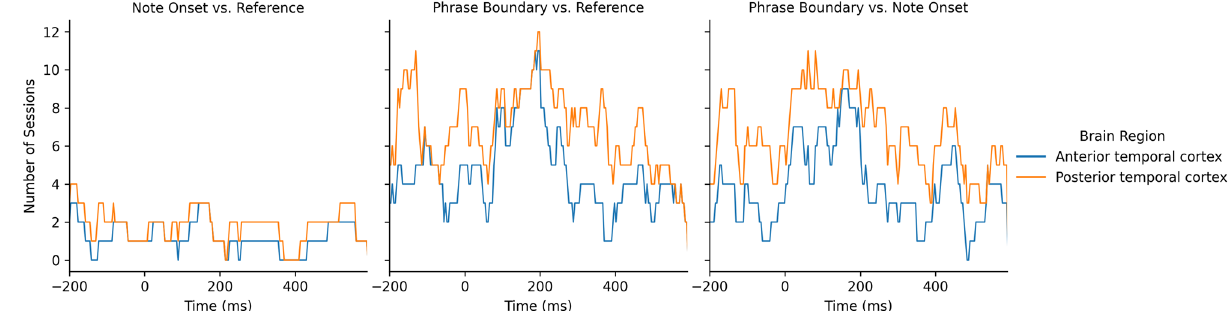
Figure 12. Number of sessions showing significant differences in the iEEG windows sampled in anterior temporal cortex and superior temporal cortex